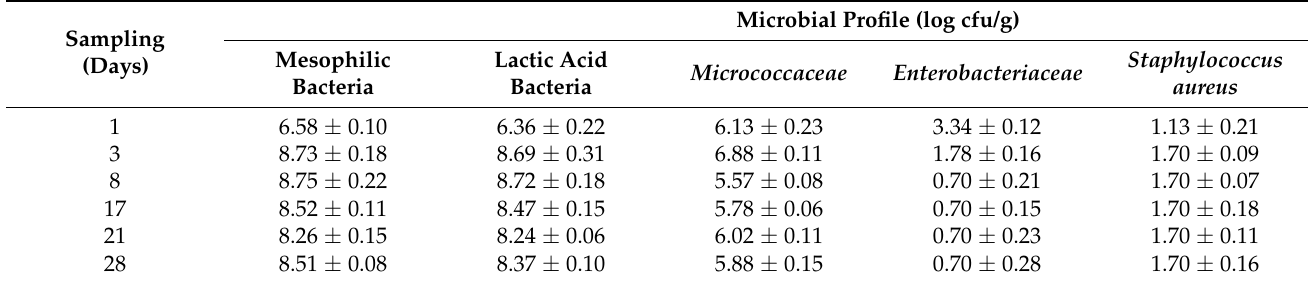
Table 4. Evaluation of the microbial flora in